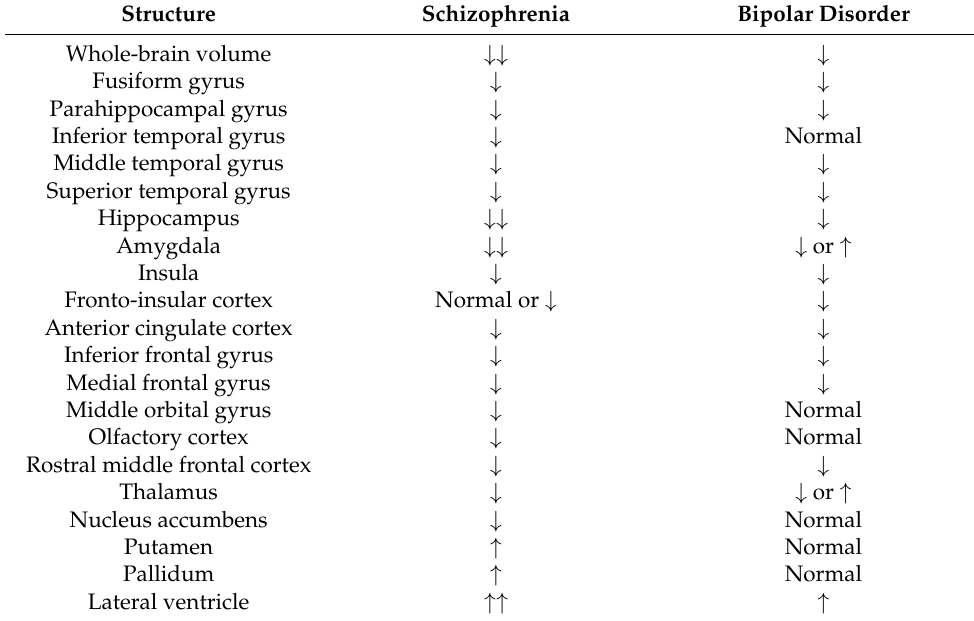
Table 1. Gray matter volume abnormalities in schizophrenia and bipolar